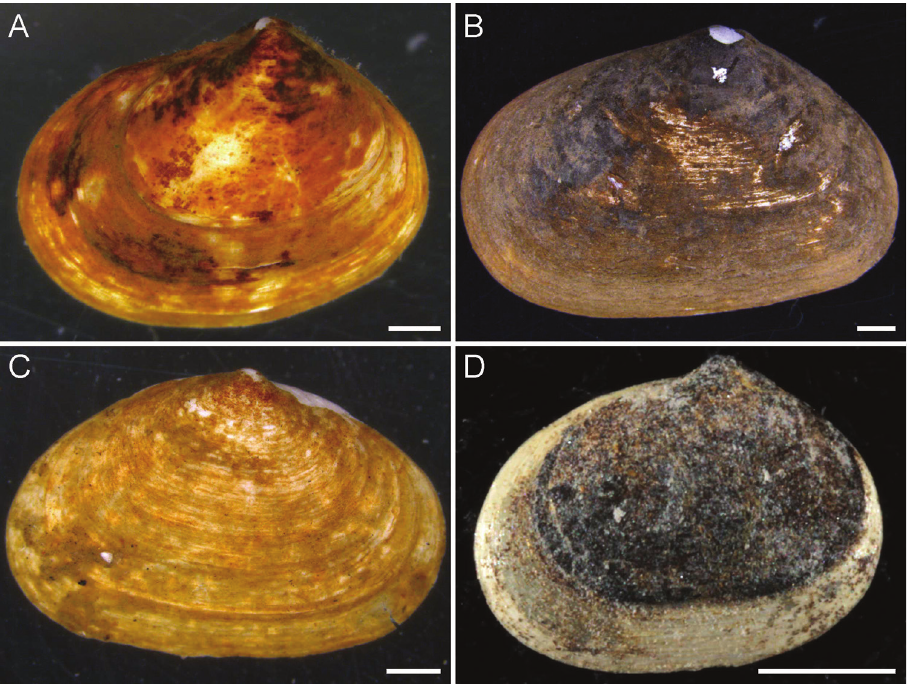
Figure 4. A Borniopsis tsurumaru (SBMNH 149526) B B. ariakensis (SBMNH 35056) C B. ocheto- stomae (SBMNH 149525) and D B. maipoensis (SBMNH 35126). Photo credits: R. Goto: A–C ; P. Valentich-Scott: D . Scale bars 1